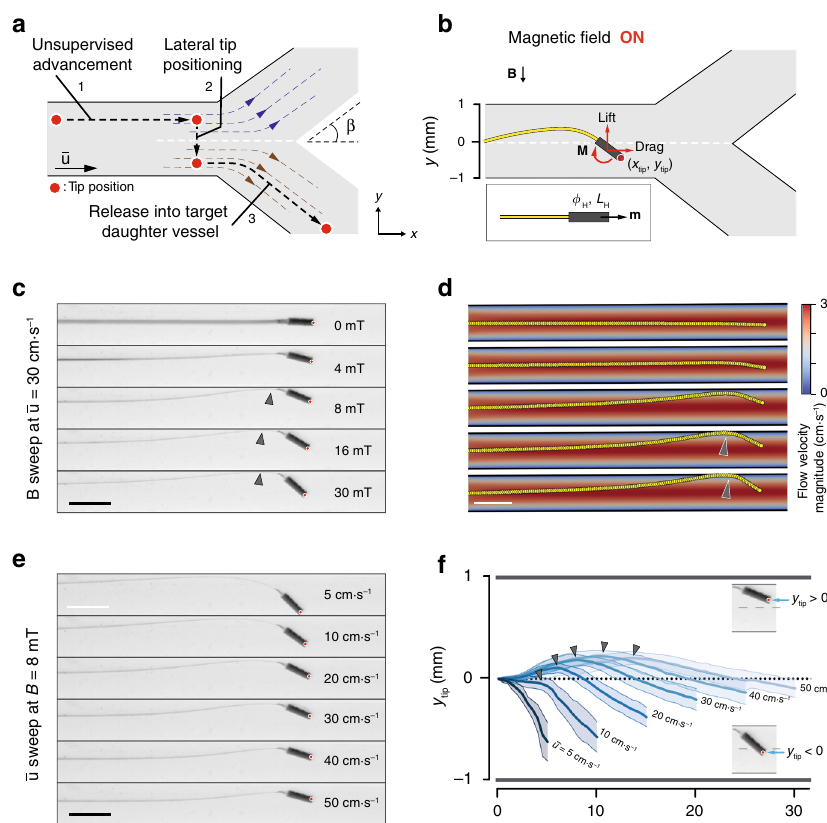
Fig. 4 Magnetic tip steering for controlling the µ -probe position. a Conceptual description of our proposed strategy to navigate the µ -probe into the target daughter vessel. Upon reaching a bifurcation, the μ -probe tip is laterally moved from the current stream (blue dashed lines) into the target stream (brown dashed lines) with the application of magnetic torque. The µ -probe is pulled into the stream with further release of the structure. Black dashed line shows the trajectory of the tip passing through the stagnation streamline (white dashed line) and β denotes the bifurcation angle. b The transversal position of the tip, y tip , is controlled by the magnetic actuation of the head that has length L H , diameter ϕ H , and magnetisation m . Upon application of the magnetic fi eld, B , the torque, M , exerted on the head rotates the head and bends the fi lament leading to an increase in both lift and drag forces. Red dot (cid:1) (cid:3) indicates the tip position. c The equilibrium shape of the µ -probe with increasing magnetic fi eld at constant fl ow velocity (cid:1) u ¼ 30cm (cid:2) s (cid:3) 1 . Red dot indicates the tip position. d Simulations of the µ -probe deformation under varying magnetic torque and constant fl ow velocity match the empirical results shown in ( c ). e The equilibrium shape of the µ -probe with increasing fl ow velocity at constant magnetic fi eld ( B = 8 mT). Red dot indicates the tip position. f The evolution of y tip in response to the fl uid velocity and magnetic fi eld sweeps. Darker lines represent the average and lighter areas represent the average ± standard deviation. Each measurement was repeated three times for both magnetic fi eld directions and for three different µ -probes ( n = 18). Grey arrows indicate contact with the channel wall. Scale bars, 2